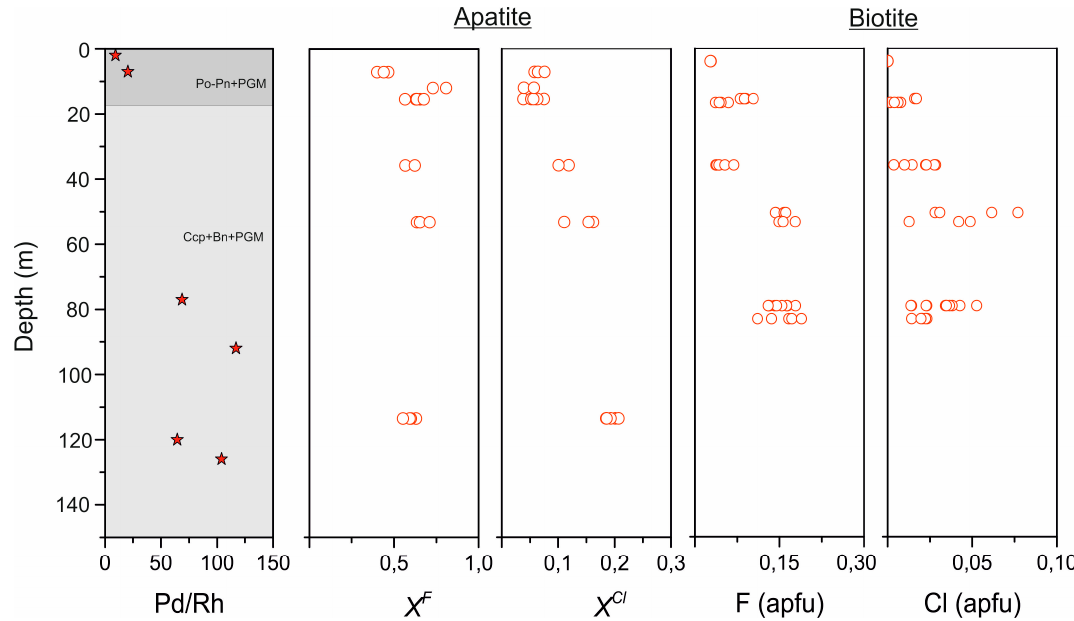
Figure 13. A simplified plot of variation of X Cl and X F in apatite and atomic proportions per formula unit of Cl and F in biotite versus Pd/Rh ratios in the mineralized drill core. Pd/Rh data are from a previous study [22]. The top of the plots coincides with the intrusion-footwall contact. (Po = pyrrhotite, Pn = Pentlandite, Ccp = Chalopyrite, Bn = Bornite, PGM = Platinum Group Minerals).